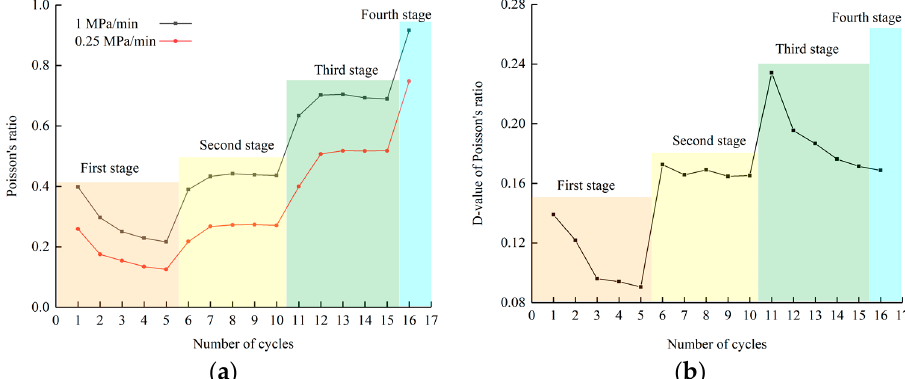
Figure 12. ( a ) Poisson’s ratio under cyclic unloading path; ( b ) The gap of Poisson’s ratio between C-1 and C-2.